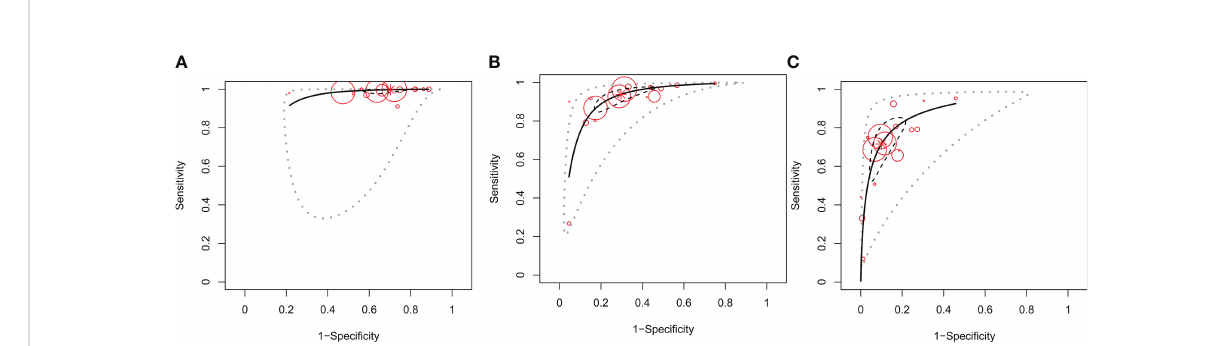
FIGURE 4 SROC of C-TIRADS 4 in detecting malignancy. SROC analysis showing the diagnostic performance of C-TIRADS 4A (A) , 4B (B) , and 4C (C) . The summary point is indicated by the red star; each individual study is represented by red circles (scale = study sample size). The area enclosed by the inner (black line) and outer (gray line) ellipses represents the con fi dence region and the prediction region of the summary points. SROC, summary receiver operating curve; C-TIRADS, Chinese thyroid imaging reporting and data system.